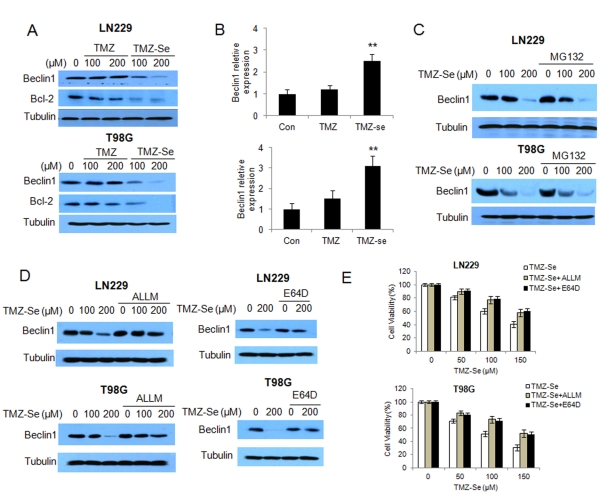
TMZ-Se induces calpain-mediated degradation of Beclin 1.LN229 and T98G cells were treated with 100 or 200 µM of TMZ or TMZ-Se for 48h, (A) the levels of Beclin 1 and Bcl-2 were measured by Western blot. Tubulin was used as a loading control; (B) the expression of beclin1 mRNA was measured by qRT-PCR. (C) LN229 and T98G cells were treated with 100 or 200 µM of TMZ-Se for 48h in the presence or absence of 10µM of MG132, and the level of Beclin 1 were measured by Western blot. Tubulin was used as a loading control. (D) LN229 and T98G cells were treated with TMZ-Se for 48h in the presence or absence of 20µM ALLM (left panel) or 10µg/ml E64D (right panel), and the level of Beclin1 was measured by Western blot. Tubulin was used as a loading control. (E) LN229 and T98G cells were treated with TMZ-Se for 48h in the presence or absence of 20µM ALLM or 10µg/ml E64D, and cell viability was measured by MTT assay. **p < 0.01.